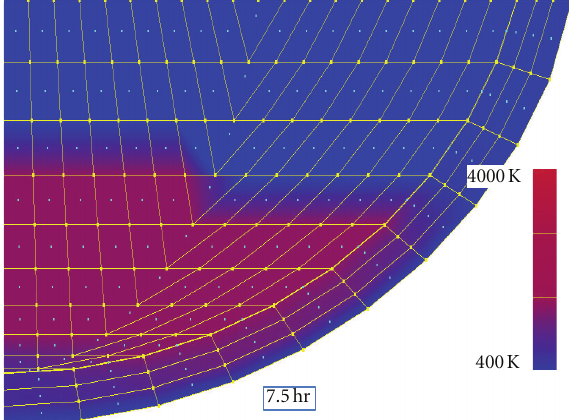
Figure 17: Temperatures in lower plenum at 7.5 hours for a scenario with depressurization and termination of emergency water injection at 4.2 hours after reactor scram (CRD flows maintained).